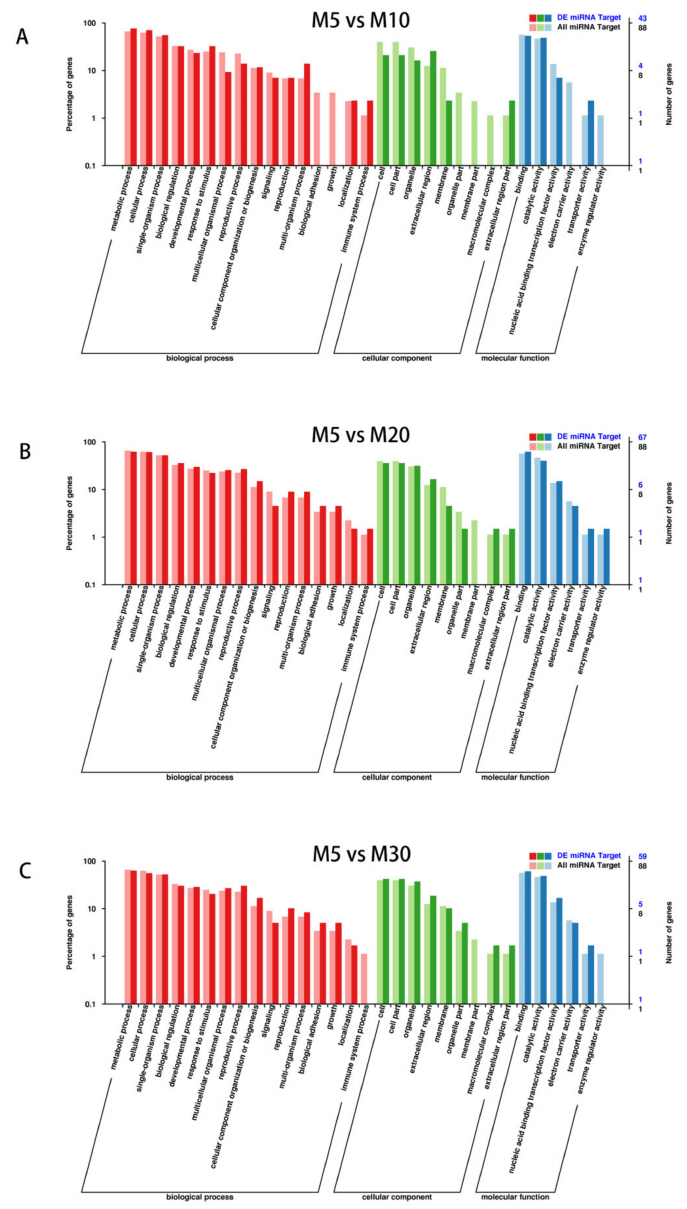
Figure 3. Gene ontology classifications of miRNA targets and di ff erentially expressed targets in seed development. ( A ) M5 vs. M10, ( B ) M5 vs. M20, ( C ) M5 vs.